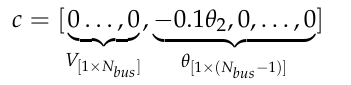
. Figure 5 is the histogram of